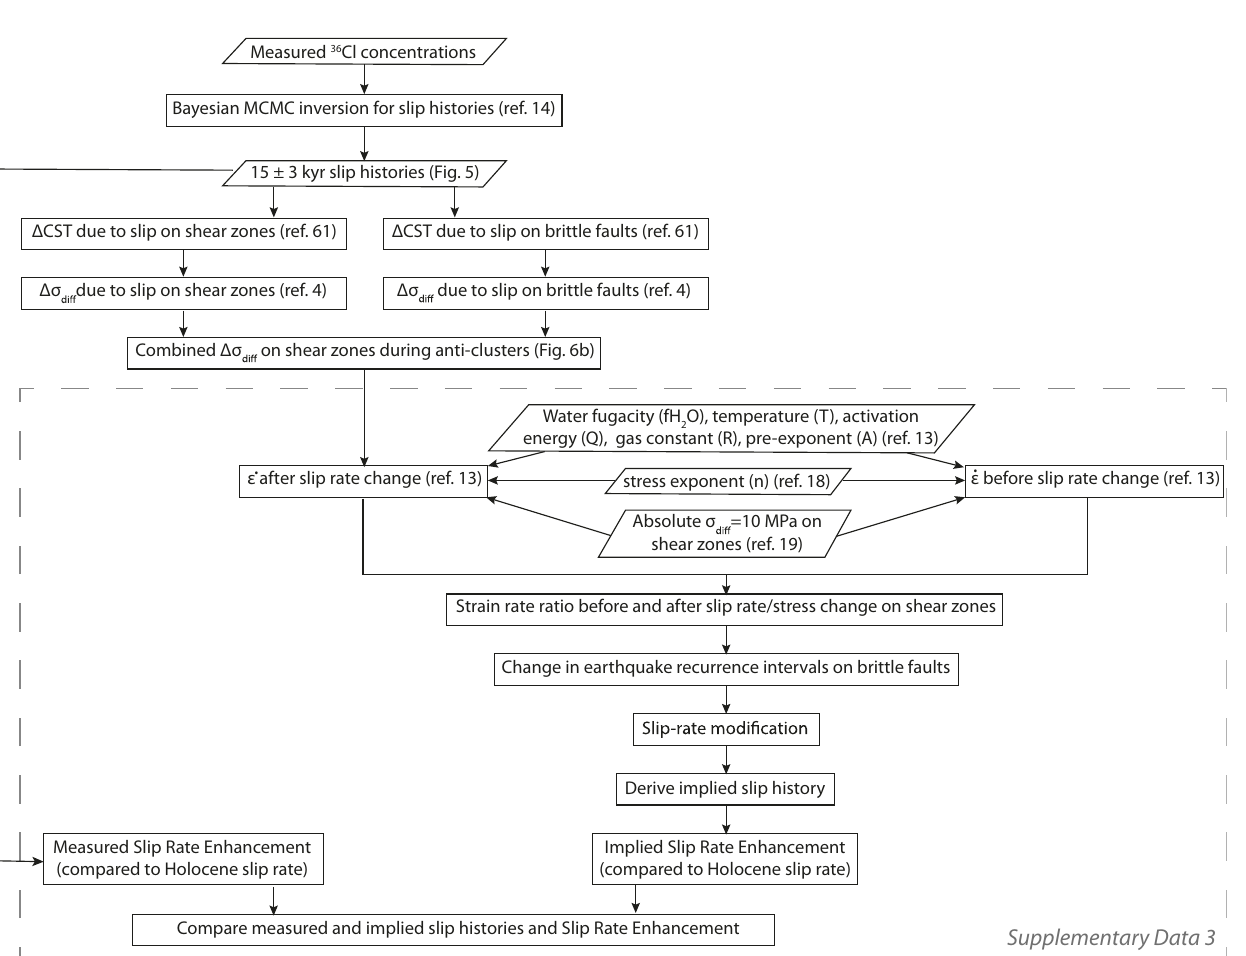
represent processes in our modelling work fl ow. The steps contained within the grey dashed line are contained within Supplementary Dataset